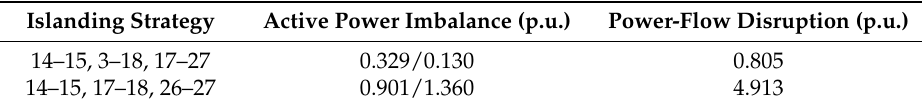
Table 4. Comparison of the islanding surface searching algorithms.